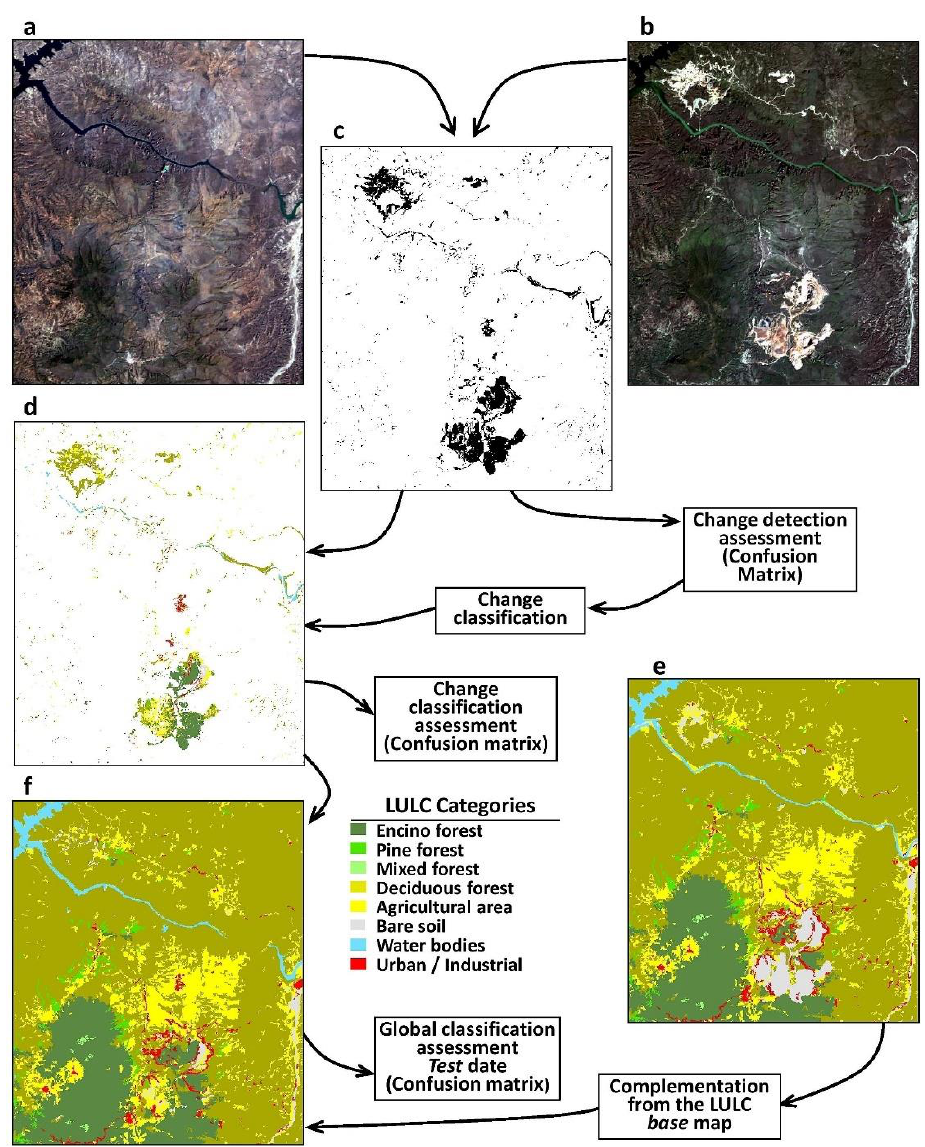
Figure 5. Test date LULC map (generated through change detection). ( a ) Test date image, ( b ) Base date image, ( c ) Change detection map, ( d ) Classification of the change detected pixels, ( e ) Base LULC map, and ( f ) Final test date LULC map.